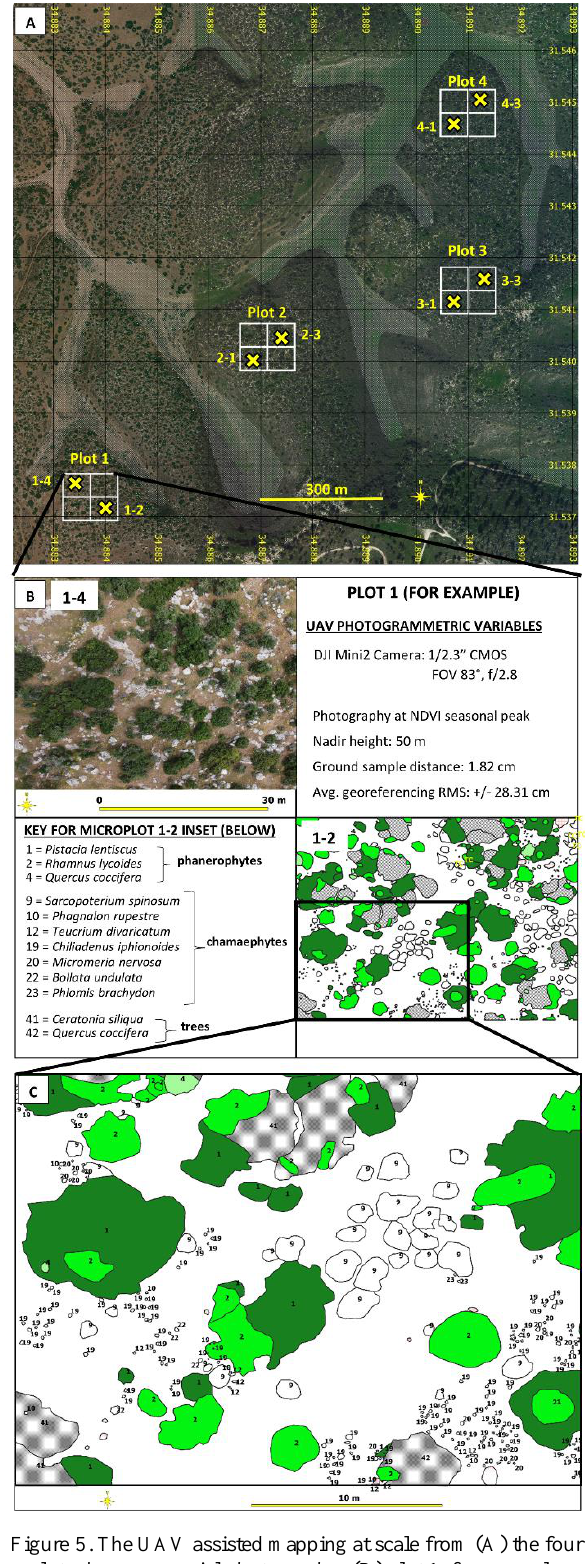
Figure 5. The UAV assisted mapping at scale from (A) the four plots shown on aerial photography; (B) plot 1, for example, with two microplots: microplot 1-4 shown as the UAV nadir photo and microplot 1-2 shown as the digitized product after mapping the vegetation; (C) inset from microplot 1-2, for example, with a legend to demonstrate the phanerophyte matrix with inter-patch chamaephyte